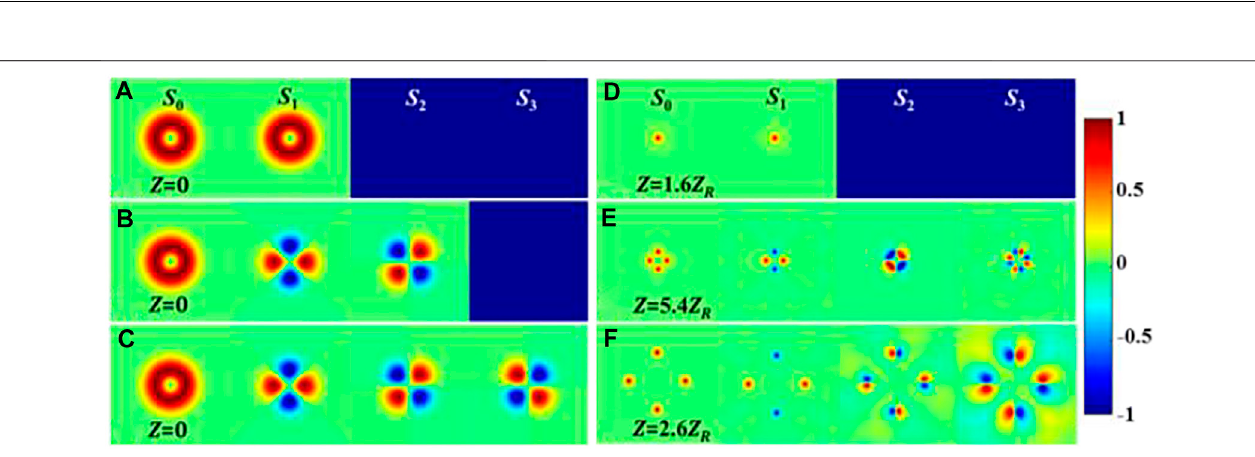
FIGURE 5 | Stokes polarization parameters for three beam models at the source plane (i.e., (A) HGB, (B) RPB, and (C) AVHP) and at the corresponding focusing spot (i.e., (D) HGB ( z (cid:2) 1 . 6 z R ), (E) RPB ( z (cid:2) 5 . 4 z R ), and (F) AVHP ( z (cid:2) 2 . 6 z R )).